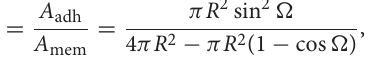
30 µ m 2 and A mem 257 µ m 2 , and (D) A adh 105 µ m 2 and = = =